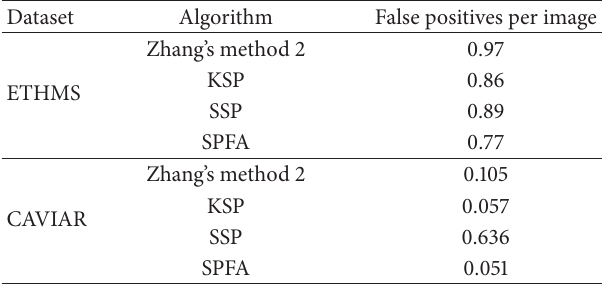
Table 2: Our algorithm’s performance compared with the state-of- the-art methods for the ETHMS and CAVIAR